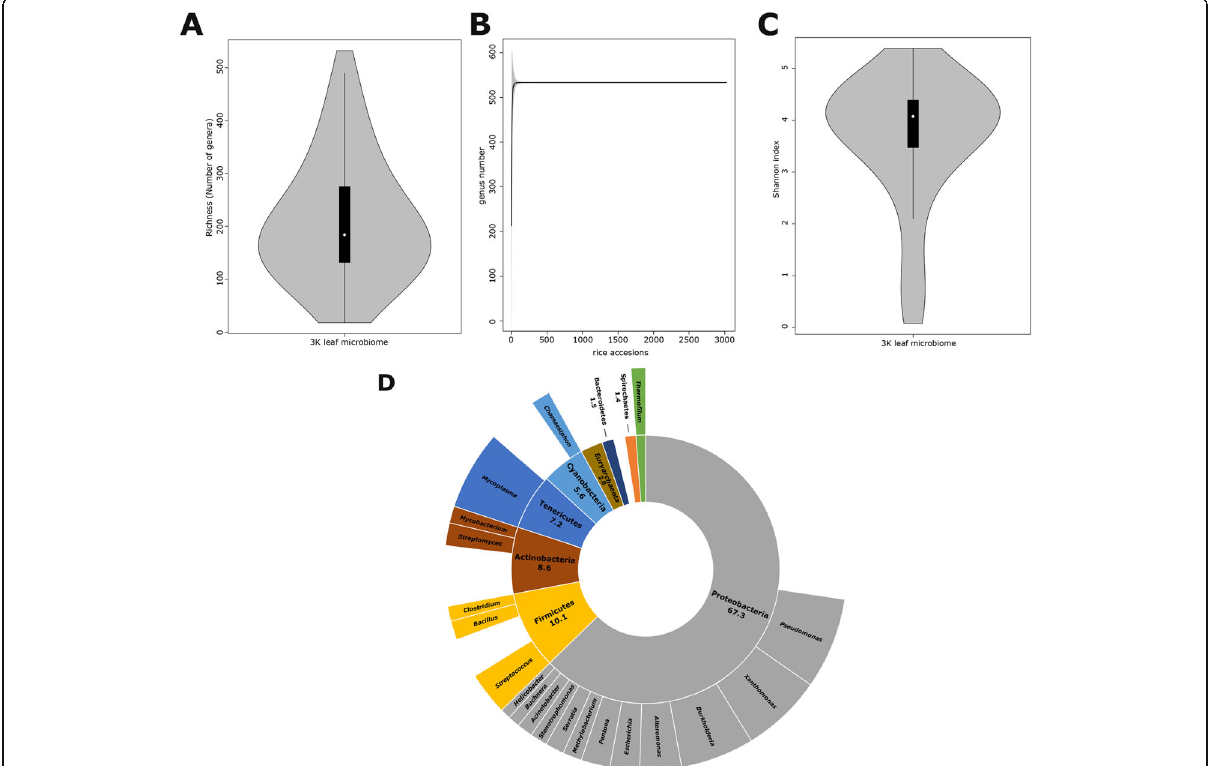
Fig. 1 Composition of leaf bacterial community in the 3K rice genome project. a , b total leaf bacterial and archaea genera ( a ) and accumulation curves ( b ) in 3024 rice genome accessions. The shade on the curve represents the confidence interval of two in the curve points. c Shannon index in all rice accessions. In the violin plots, the black box plot indicates the 75th and 35th percentile. The white dot represents the media. d Relative abundance at phylum and genera level. The inner position of the sunburst chart represents phylum and the outer position represents Genus. The chart shows average relative abundance higher than 1% across all